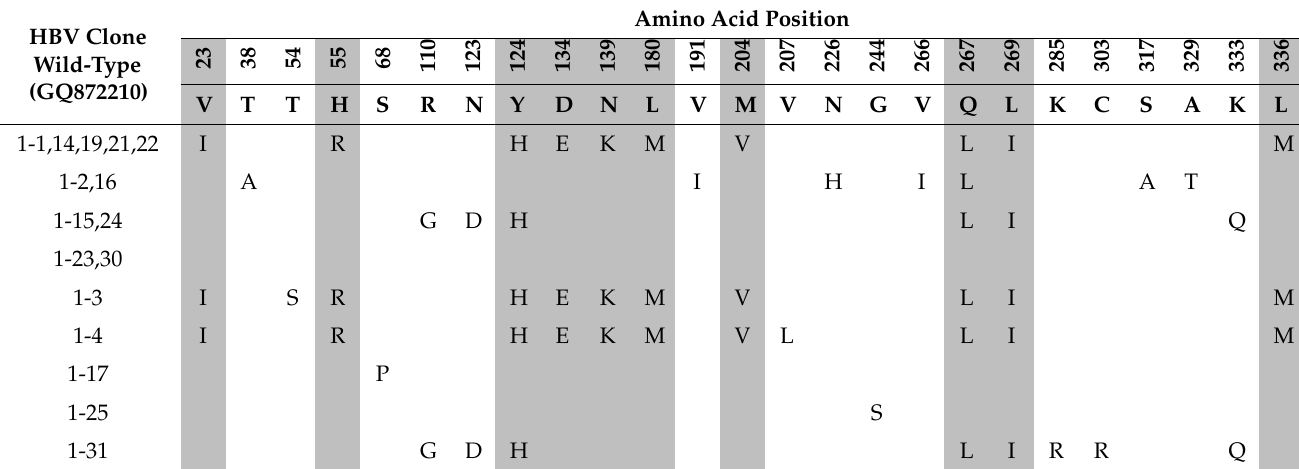
Table 2. HBV RT mutations isolated from the BSV-treated